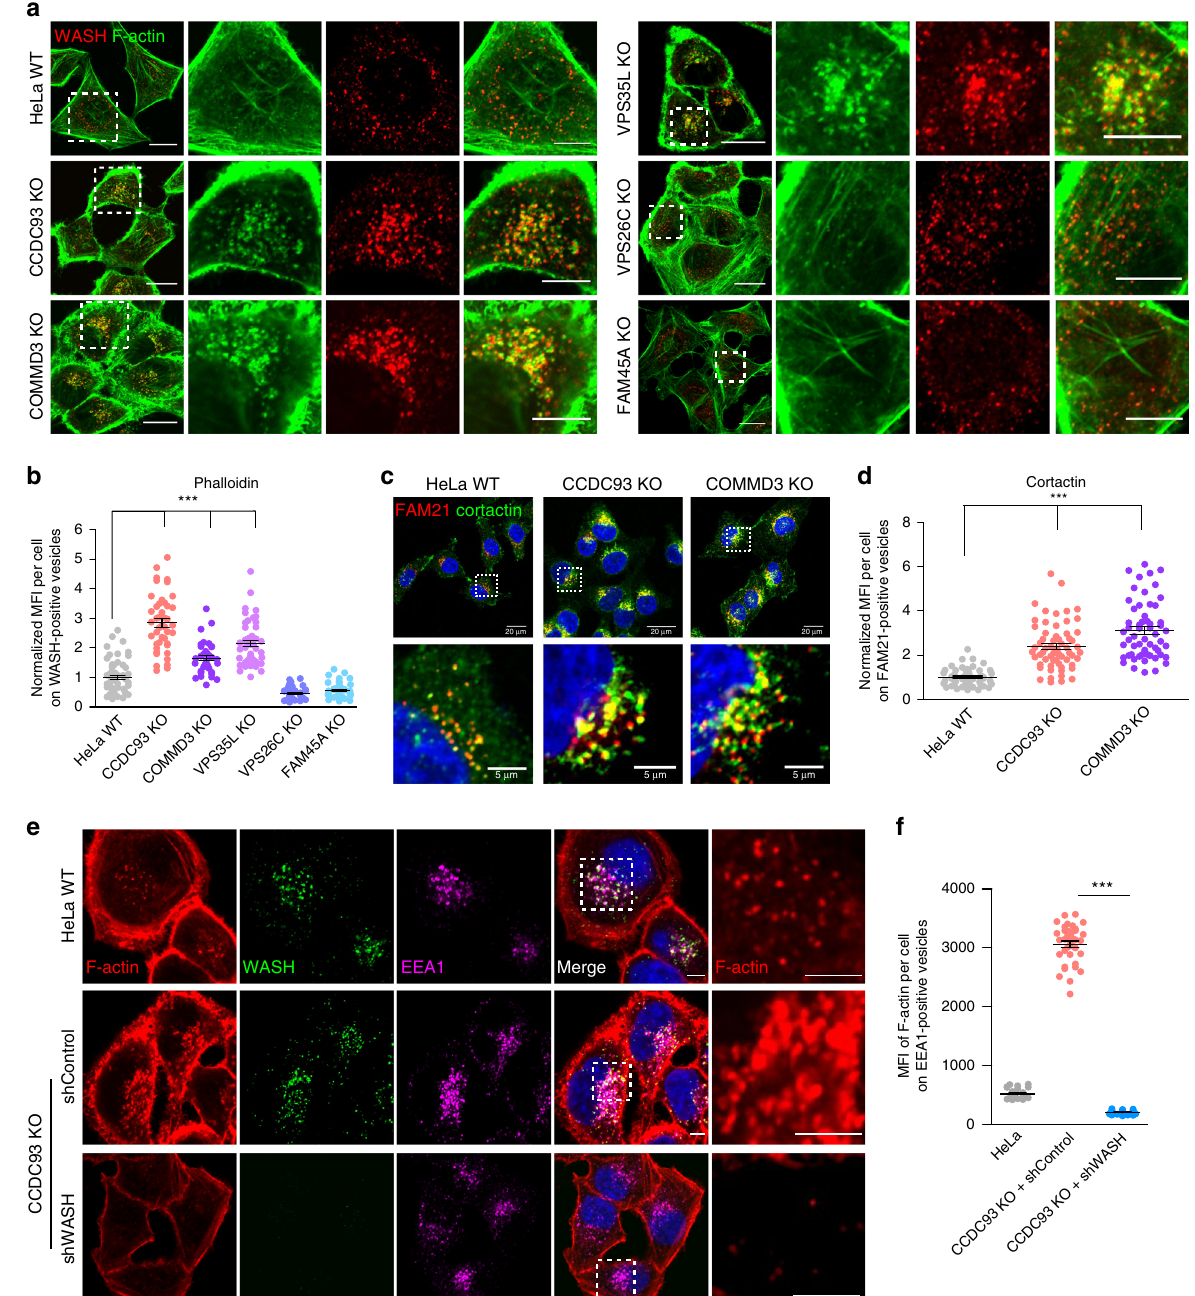
Fig. 3 CCC depletion leads to WASH-dependent increase in endosomal F-actin. a Confocal imaging for F-actin and WASH immuno fl uorescence staining of HeLa WT and the indicated CRISPR/Cas9 knockout cell lines. Representative images of three independent experiments are shown. Scale bars 20 μ m, for zoomed images 10 μ m. b Quanti fi cation of normalized mean fl uorescent intensity (MFI) of F-actin on WASH-positive vesicles from a . Results for individual cells are plotted, along with the mean and s.e.m. for each group ( n = 62 cells for WT, 45 for CCDC93 KO, 48 for COMMD3 KO, 50 for VPS35L KO, 43 for VPS26C KO, 48 for FAM45A KO); *** P < 0.0001 (one-way ANOVA and Dunnett ’ s test to control). c Confocal imaging for cortactin and FAM21 immuno fl uorescence staining in the indicated cell lines. Representative images of two independent experiments are shown. Scale bars 20 μ m, for zoomed images 5 μ m. d Quanti fi cation of cortactin immuno fl uorescence on FAM21-positive vesicles from c . Results for individual cells are plotted, along with the mean and s.e.m. for each group ( n = 51 for WT cells, 63 for CCDC93 KO, 56 for COMMD3 KO); *** P < 0.0001 (one-way ANOVA and Dunnett ’ s test to control). e Confocal imaging of F-actin, EEA1, and WASH immuno fl uorescence staining for the indicated cell lines. Representative images of two independent experiments are shown. Scale bars, 10 μ m and 5 μ m on zoomed images. f Quantitation of endosomal F-actin deposition on EEA1-positive endosomes in the indicated cell lines ( n = 35 cells for HeLa WT, 36 for CCDC93 KO shcontrol, 37 for CCDC93 shWASH). The mean MFI and the s.e.m. for each group are plotted; *** P < 0.0001 (unpaired two-tailed t test to CCDC93 KO